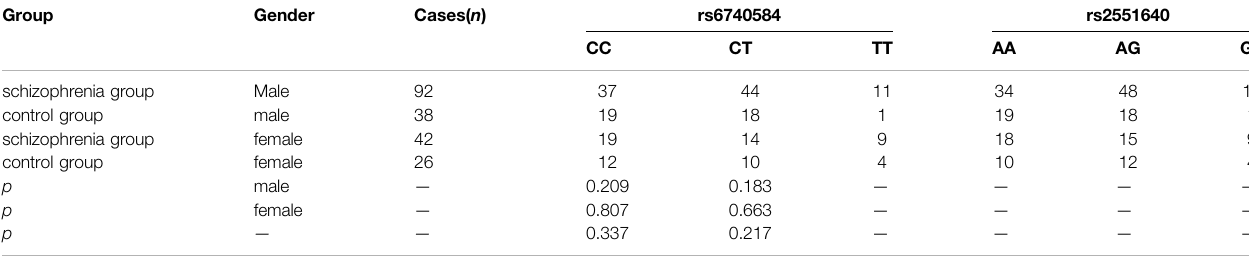
TABLE 4 | Comparison of CREB rs6740584 and rs2551640 genotype frequencies between the two groups. Group Gender Cases( n )